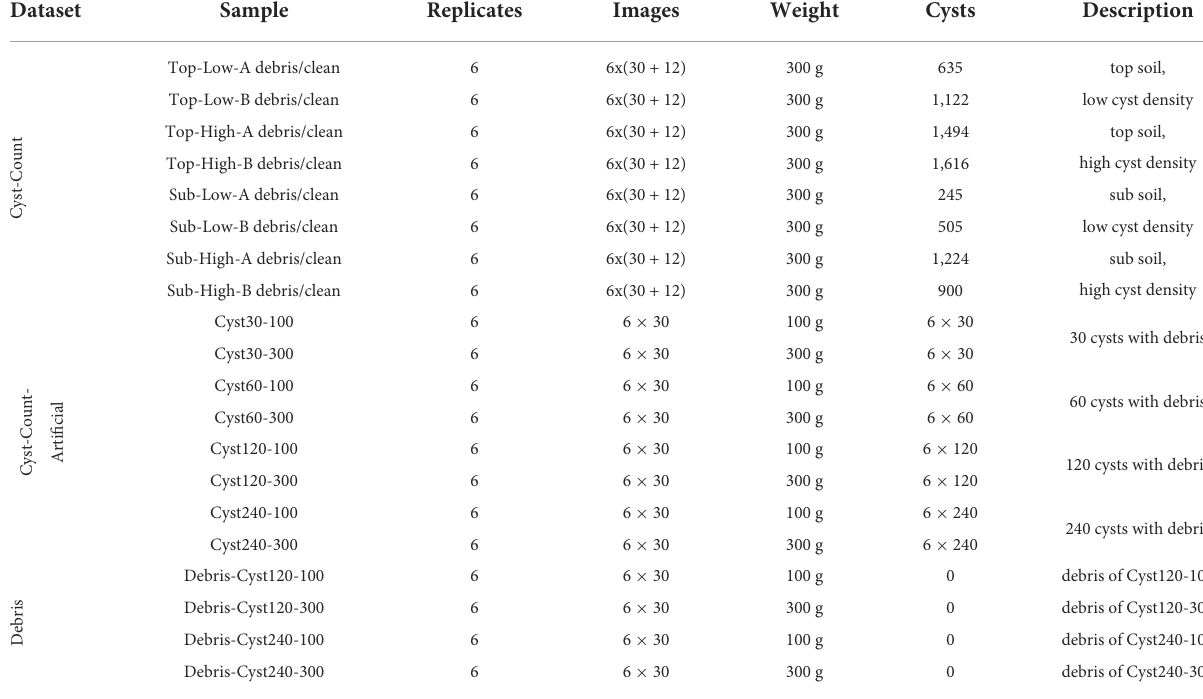
TABLE 1 Samples used for cyst count